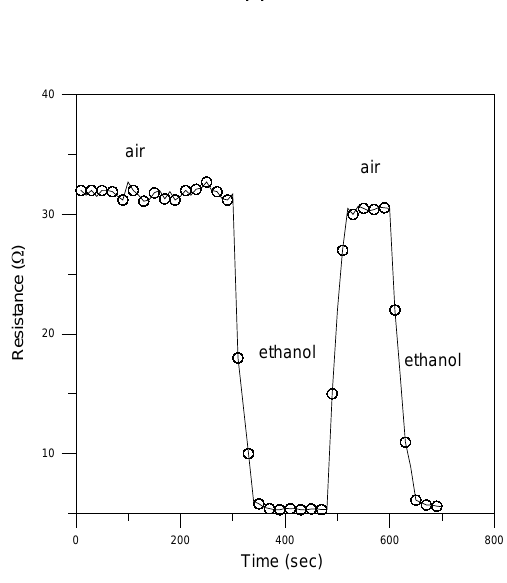
Figure 4. (a) Relationship between operating temperature and sensitivity for ZnO:Al thin film at 400 ppm.